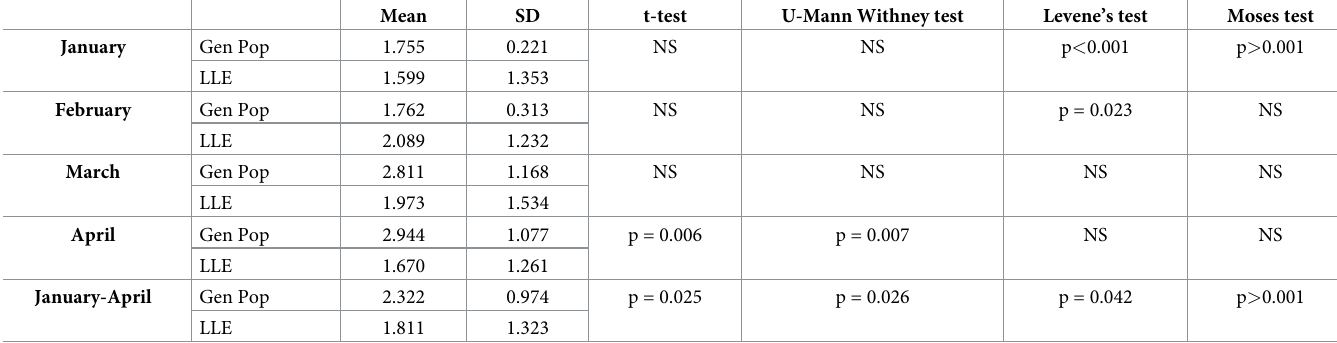
Table 2. January-April average weekly mortality rate (per 1,000) by month, according to the participation to the LLE program. Mean SD t-test U-Mann Withney test Levene’s